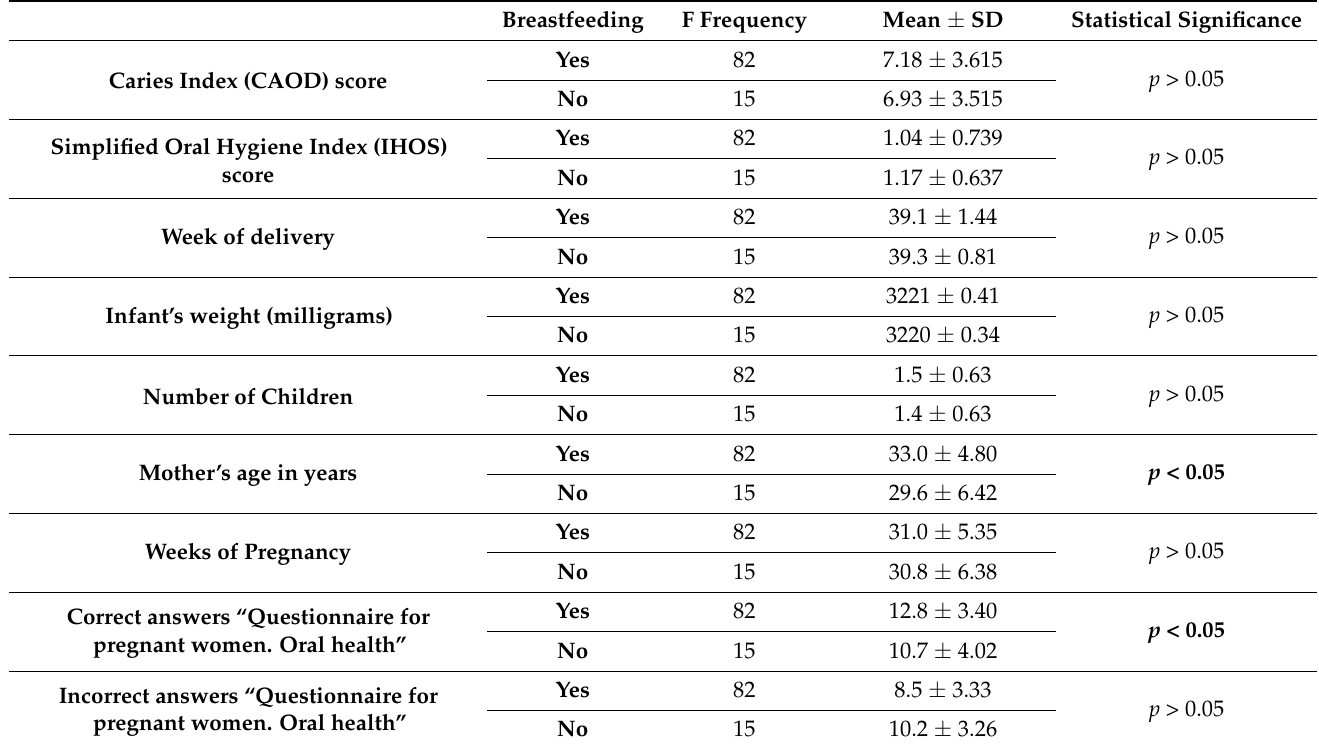
Table 2. Results of the different variables according to breastfeeding habits. Breastfeeding F Frequency Mean ± SD Statistical